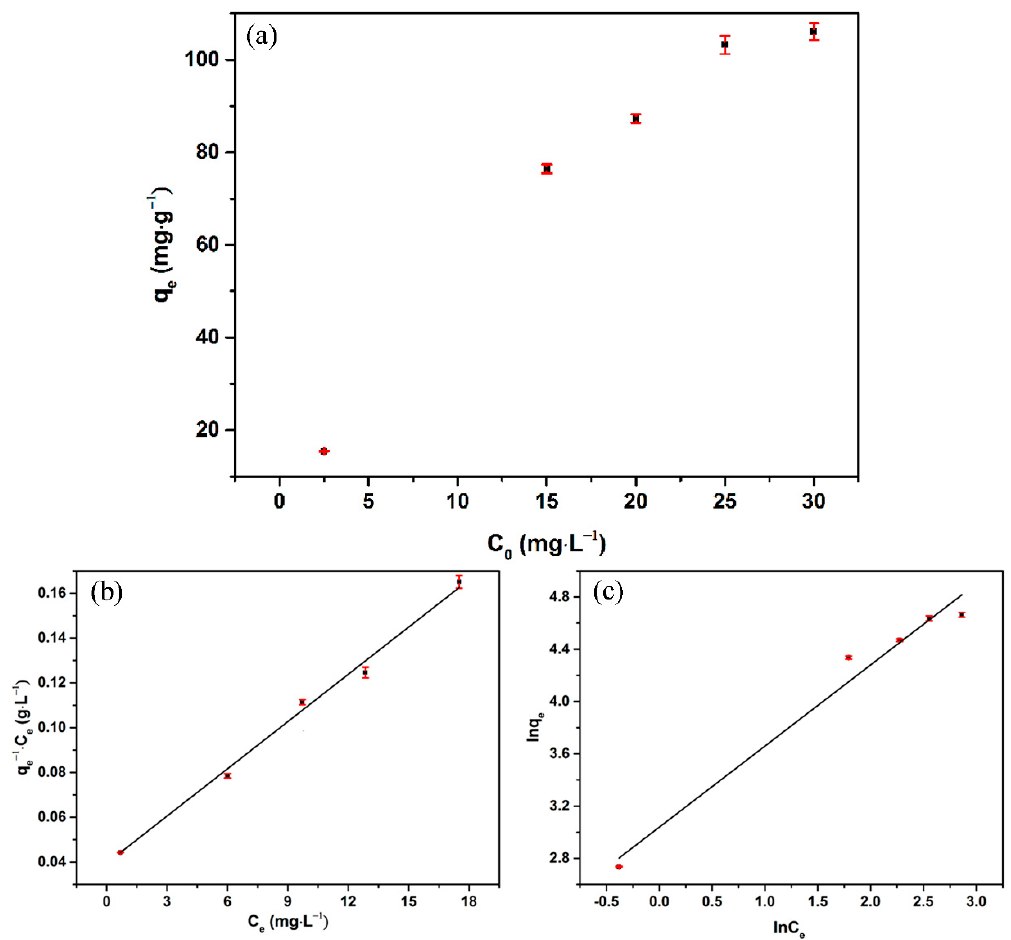
Figure 3. ( a ) Adsorption isotherms of HA/Fe 3 O 4 /OS, according to ( b ) the Langmuir equation and ( c ) ( c ) the Freundlich equation (pH = 5; contact time, 24 h). the Freundlich equation (pH = 5; contact time, 24 h). Table 1. Langmuir and Freundlich constants for the adsorption of Hg 2+ ions via HA/Fe 3 O 4 /OS. Langmuir model